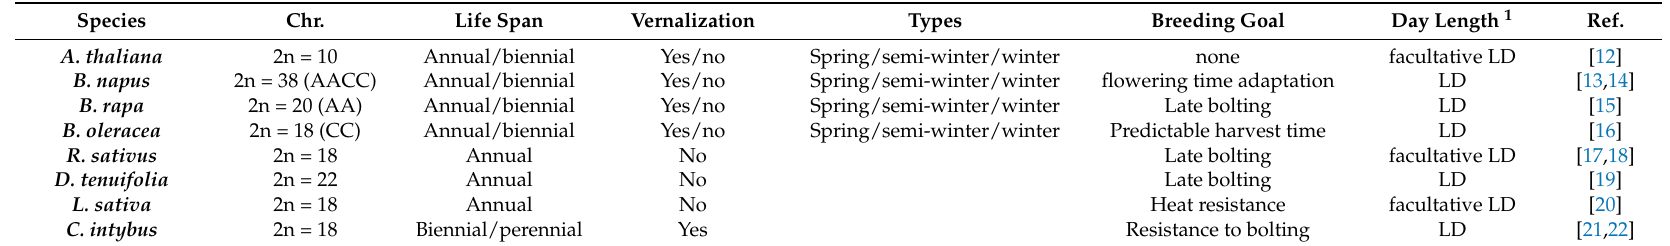
Table 2. Brief description of the plant